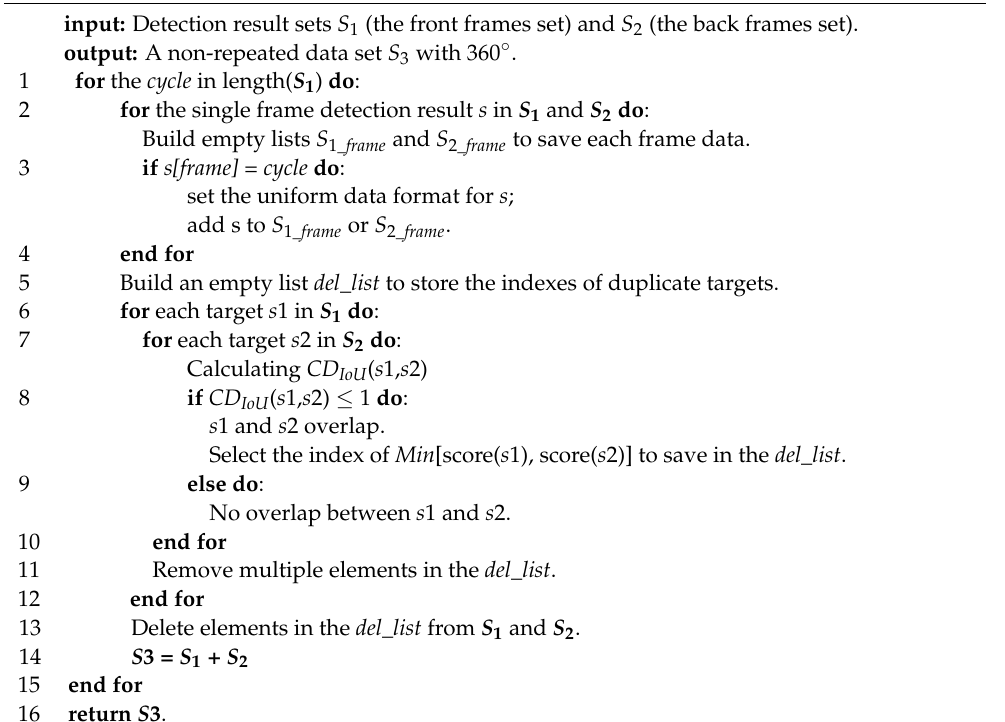
Algorithm 1 Duplicate target estimation and